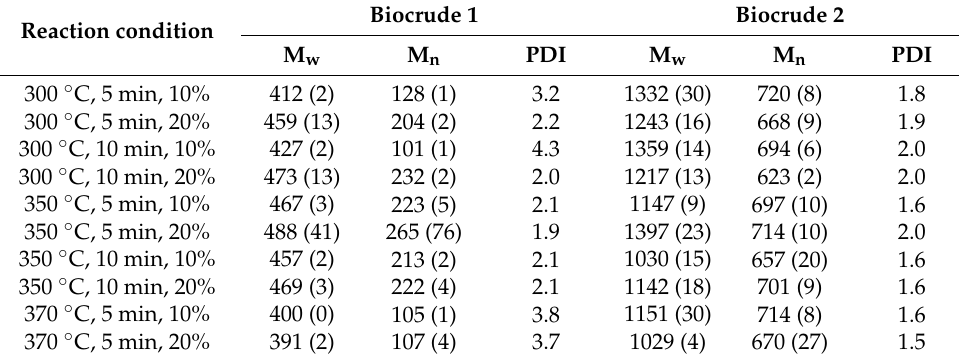
Table A7. Weight-average, number-average molar mass (in g mol − 1 ) and a polydispersity index of BC1 and BC2; the absolute standard deviation is reported in